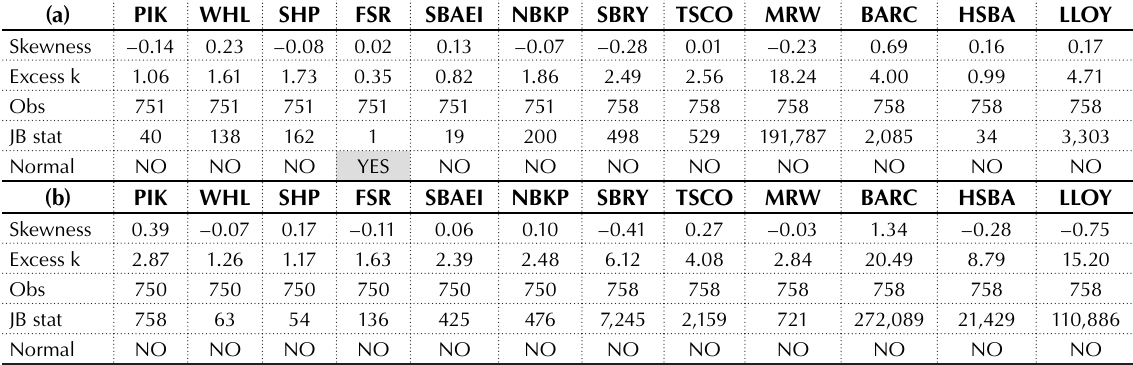
Table 4. Results of a two-sided means test at a 99% confidence level (daily returns)